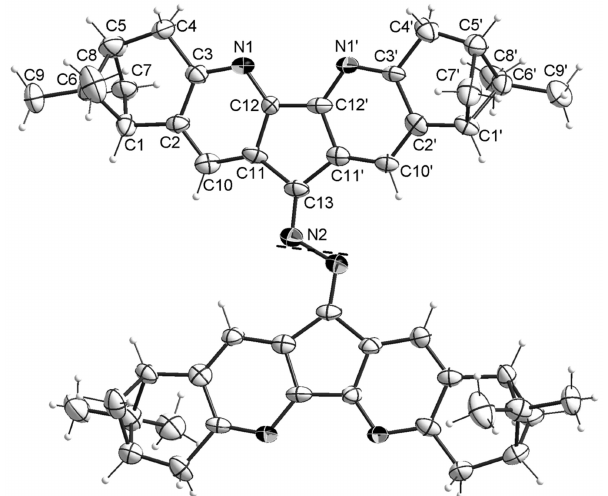
Figure 5. Thermal ellipsoid plot of 8 in the crystal structure showing 30% probability ellipsoids (the solvent molecules are not shown). C 2 axis is shown with black dashes.